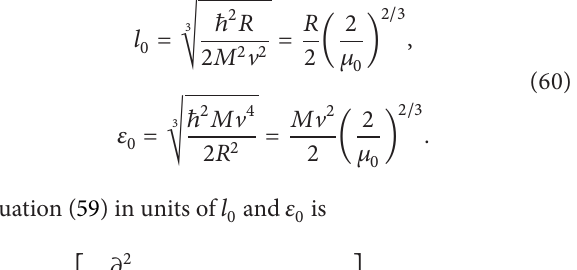
Figure 3. The value 𝜀 𝜇 can be understood as the radial motion energy within the linear expansion used above for the angular momentum |𝜇 − 𝜇 0 | ≪ 𝜇 0